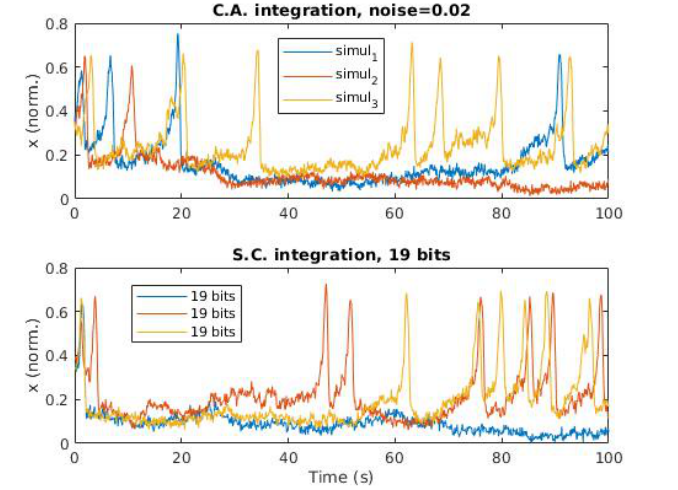
Figure 5. Comparison between three different simulation using the exact (Conventional Arithmetics, C.A.) solution ( top ) with a (cid:101) = 0.02 noise, and three different simulations using SC and 19 bits ( bottom